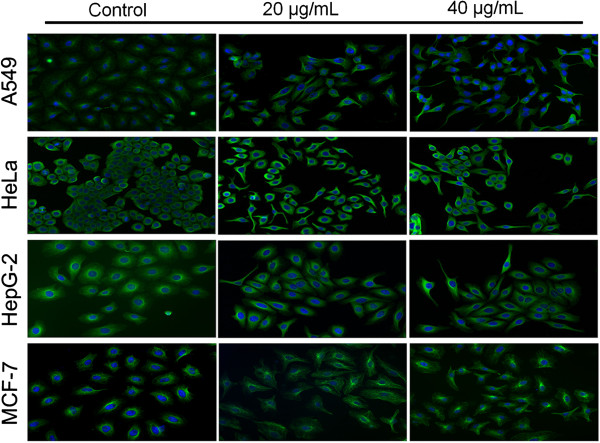
Grailsine-Al-glycoside caused changes of cell morphology in A549, MCF-7, HepG2, and Hela cells. Grailsine-Al-glycoside treated cells were stained with anti-α-tubuin antibody and conterstained with DAPI.